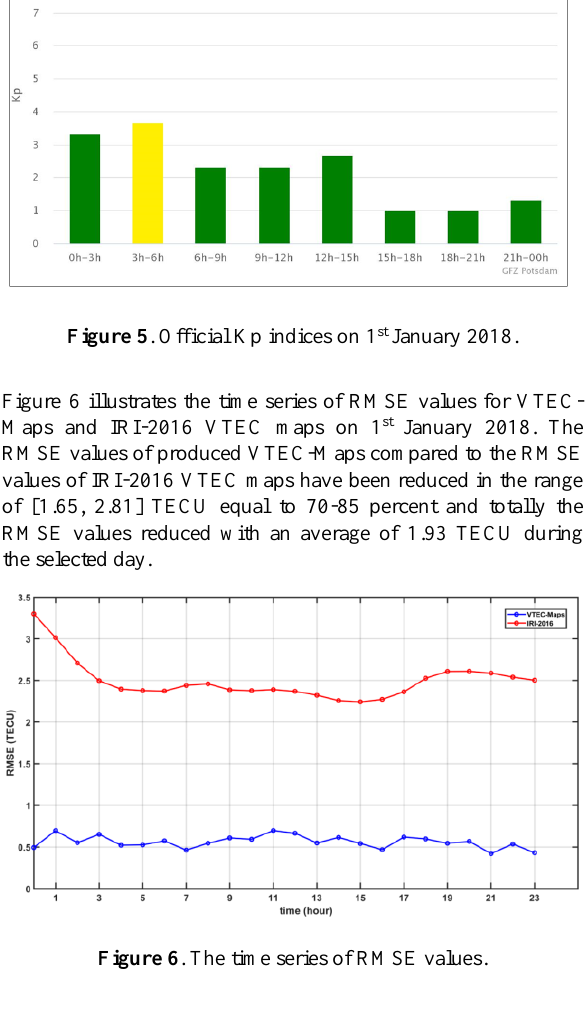
The time series of bias values for VTEC-Maps and IRI-2016 VTEC maps on 1 st January 2018 is shown in Figure 7. In this Figure, bias values of the produced VTEC maps and IRI-2016 VTEC estimates are in the range of [-0.05, 0.04] and [-1.03, - 0.30] TECU, respectively. The average decrease of the Bias was about 0.75 TECU during the day.